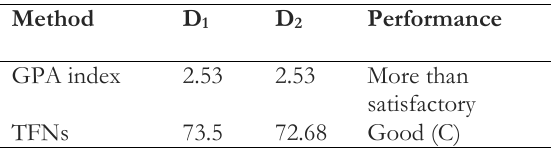
Table 2. The outcomes of Example 1.